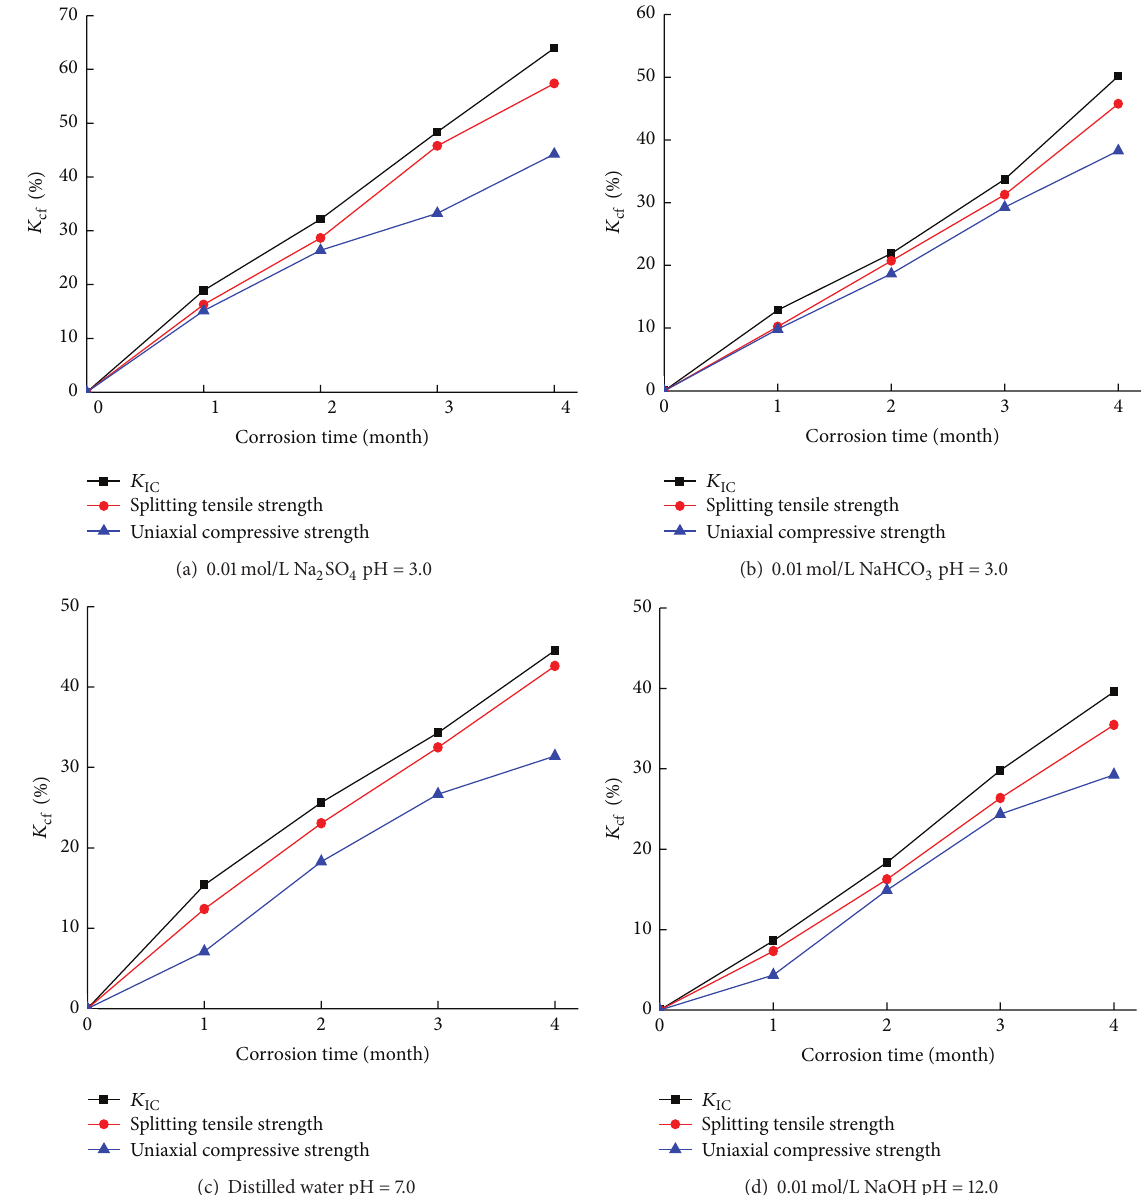
Figure 8: Relationship between the deterioration rate of the mechanical characteristics of granite specimens and corrosion time under different water chemical